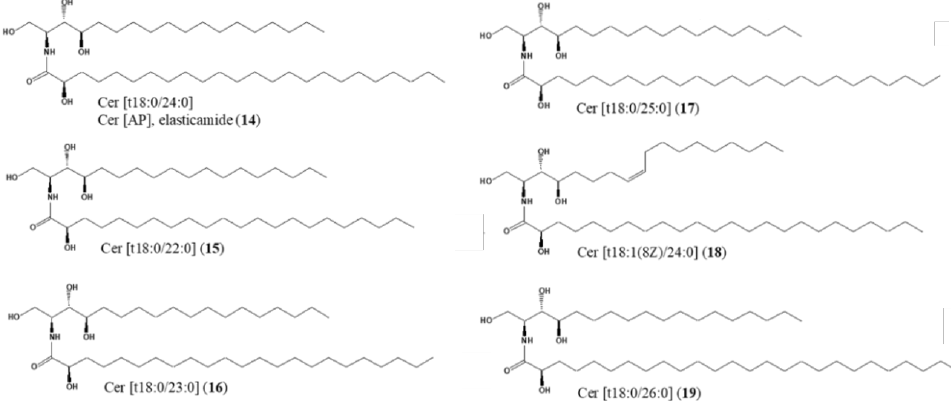
Figure 2. Chemical structures of Cer ( 14 – 19 ) isolated from GlcCer-rich rice oil by-product.